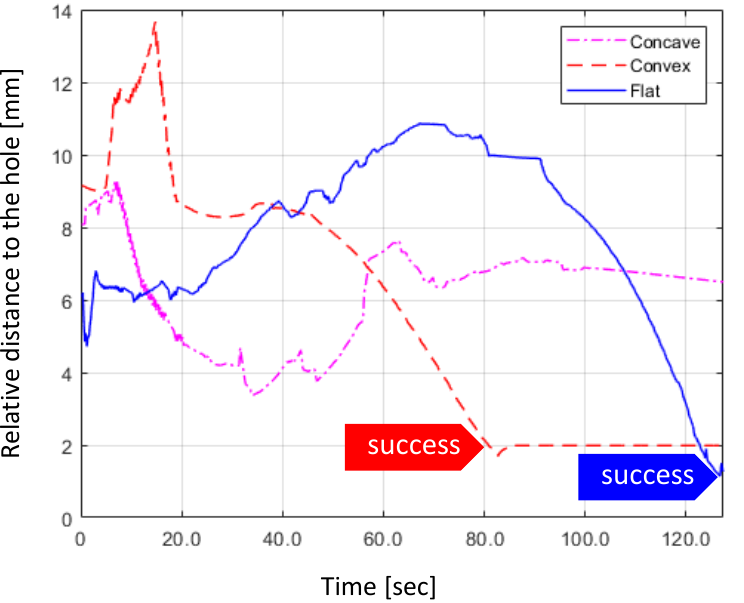
Figure 8. The comparison result of the trained robotic agent performance given the virtual GS cubes of the flat plane, convex plane, and the concave plane in terms of success/failure and task completion time in the simulation